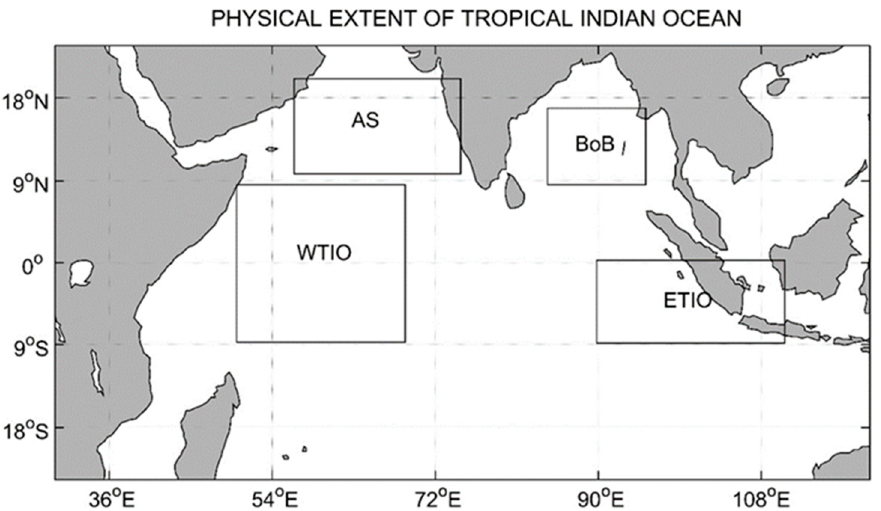
Figure 2. Geographical extent of the TIO (23.5° S–23.5° N, 30–120° E). The black boxes represent the areas of study: ETIO (10° S–Eq, 90–110° E), WTIO (10° S–10° N, 50–70° E), AS (12–24° N, 55–75° E), and BoB (10–20° N, 80–100° E). The BoB region is included in this study for analysis of precipitation variability.